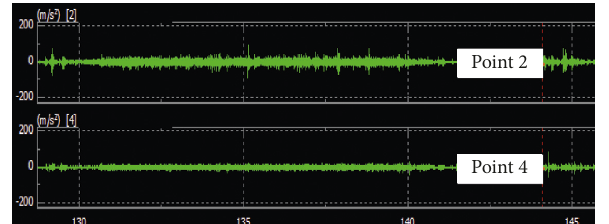
Figure 17: Test results in time domain.